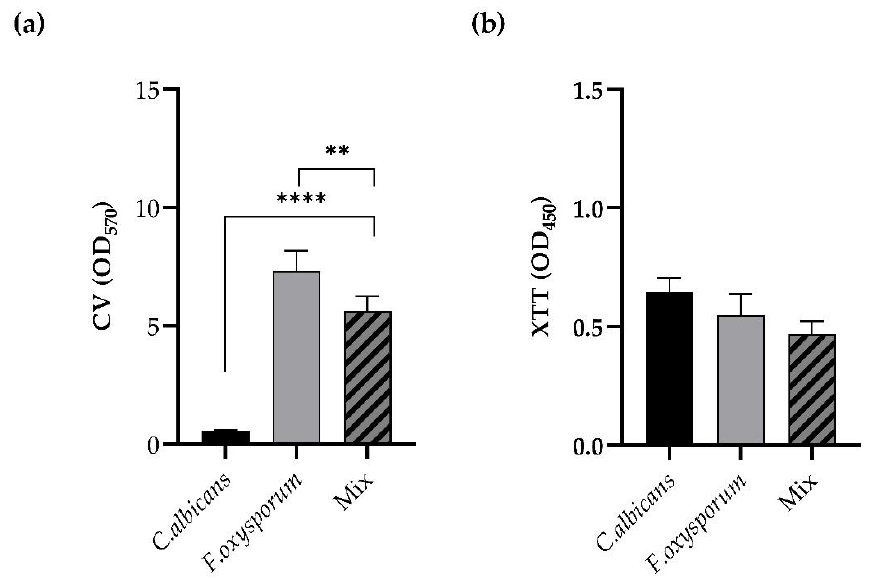
Figure 1. Panel ( a ): Comparison between the total biomass of monospecies biofilms of C. albicans and F. oxysporum with the dual-species biofilms formed by C. albicans/F. oxysporum starting from a ratio of 1:1. Panel ( b ): Comparison between the metabolic activities of monospecies biofilms of C. albicans and F. oxysporum and the dual-species C. albicans/F. oxysporum biofilm formed starting from a ratio of 1:1. Statistical significance: ** p < 0.01; **** p < 0.0001 ( Tukey’s test ).